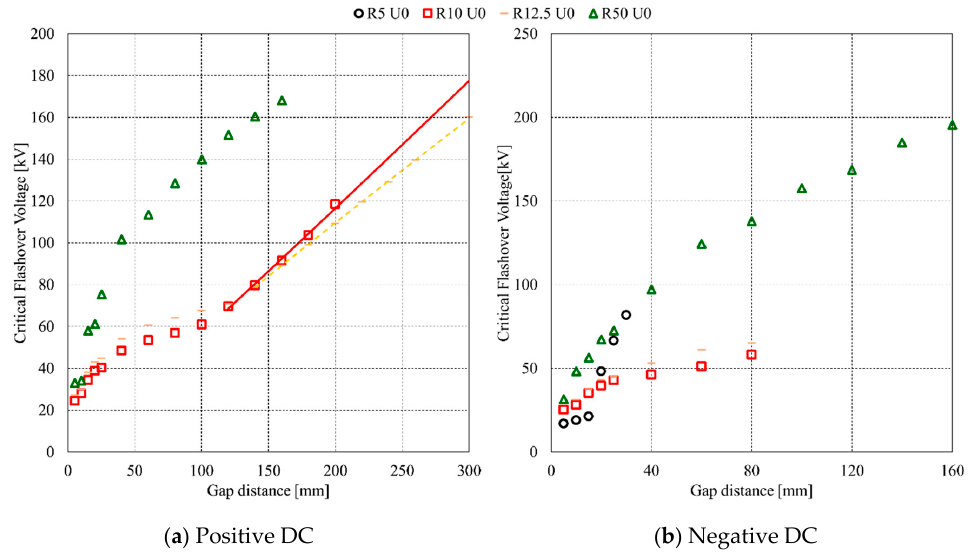
Figure 8. The flashover experiment results of DC. Energies 2020 , 13 , x FOR PEER REVIEW